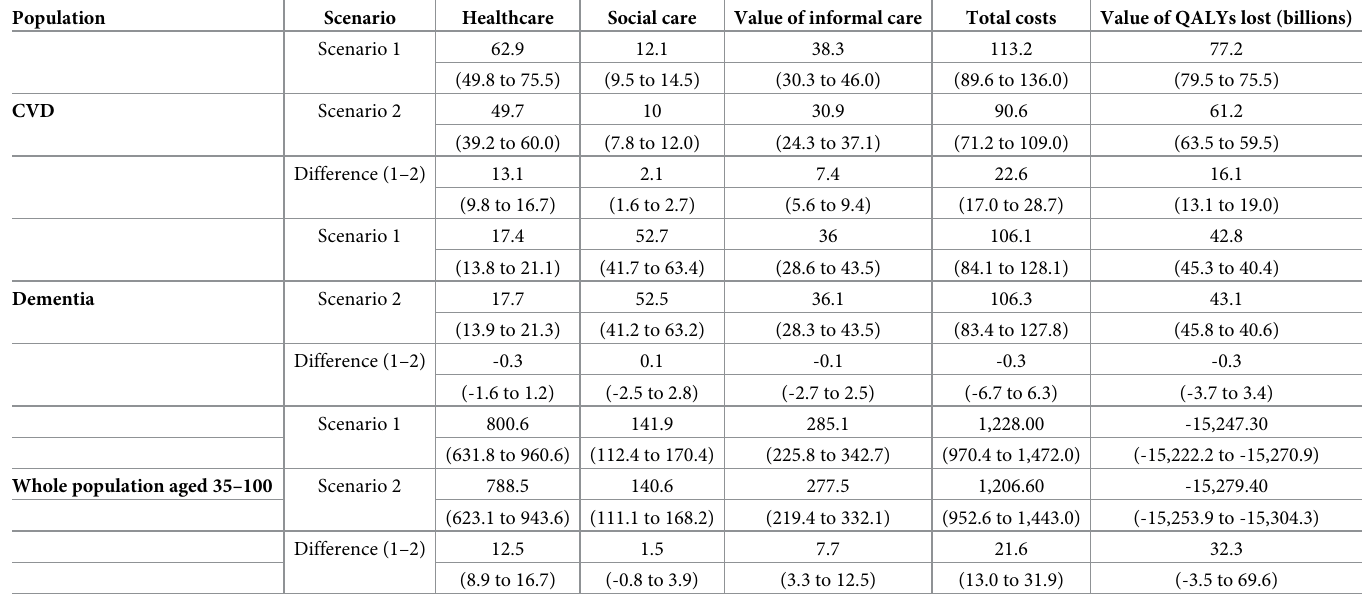
Table 4. Total cumulative undiscounted health and social care costs, value of informal care, and value of QALYs (where 1 QALY valued at £60,000) for adults aged 35–100 in England and Wales, over 10 years from